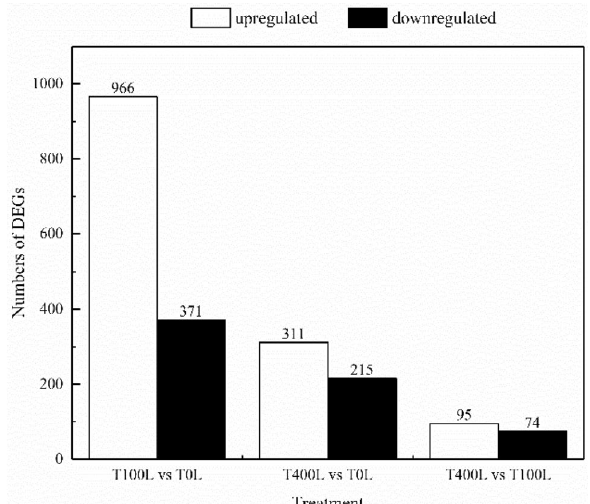
Figure 2. Number of DEGs in N. sibirica treated with different concentrations of